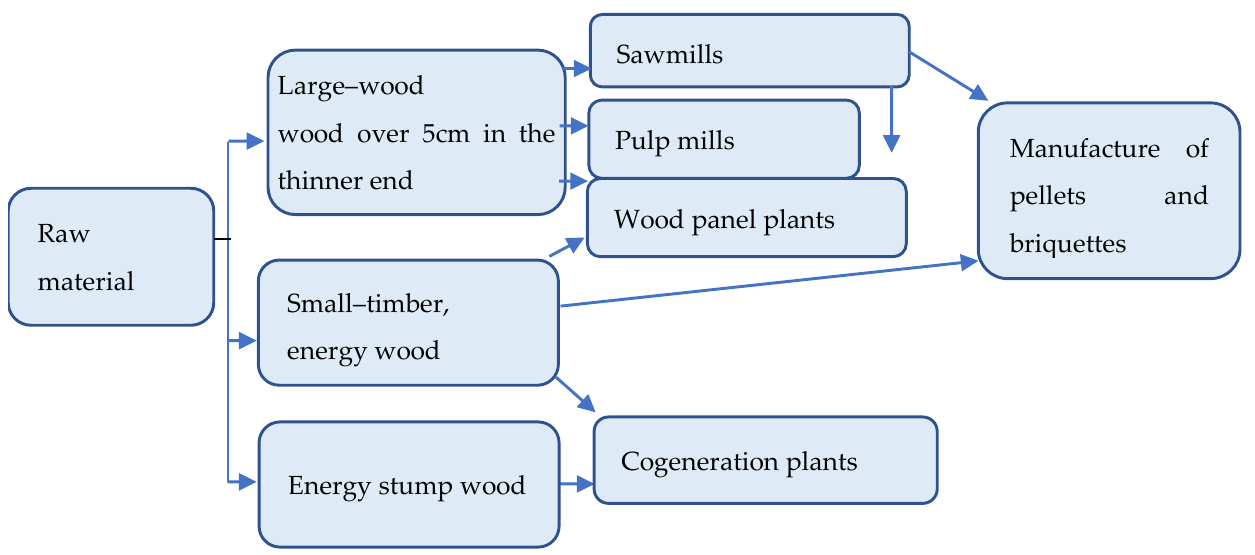
Figure 3. The directions of wood distribution. Source: own elaboration.